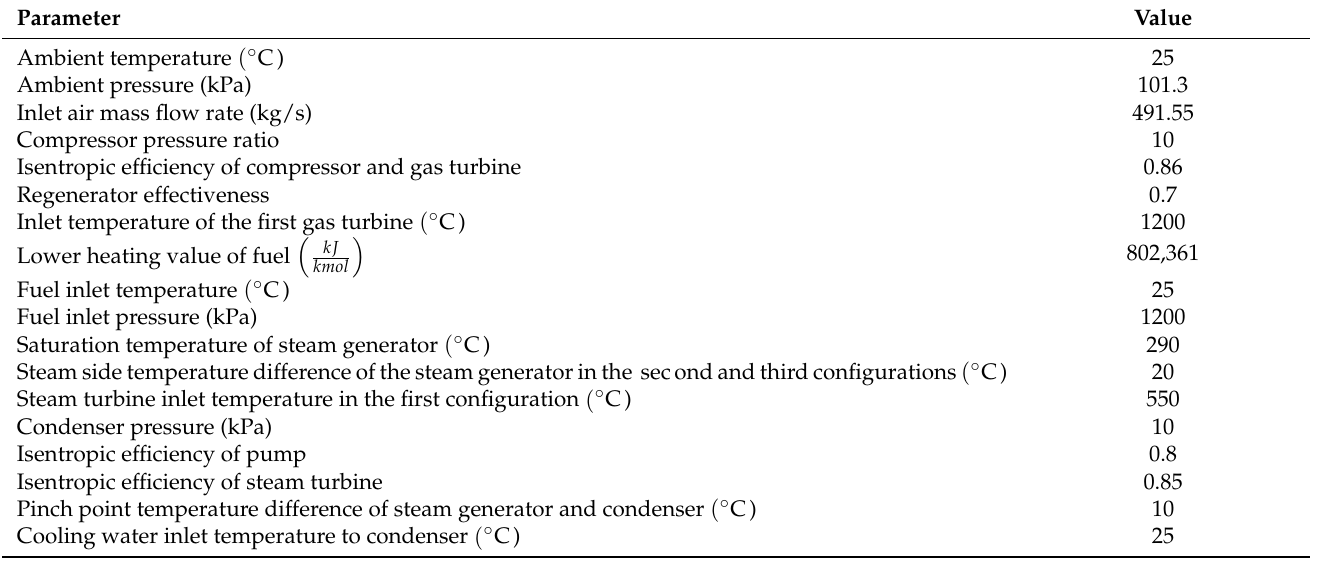
Table 7. Input data to simulate the combined cycle systems shown in Figures